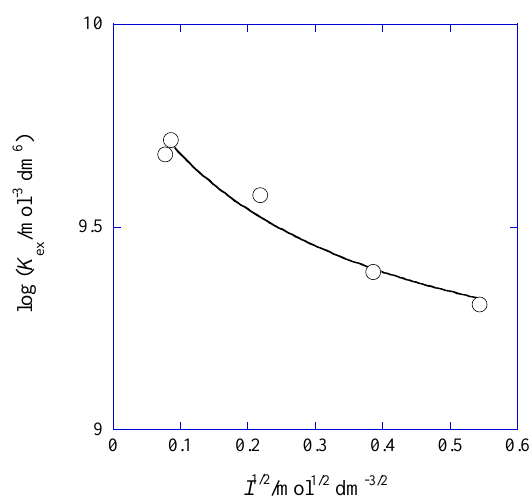
Figure 5. Plot of log K ex versus I 1/2 for the Pb(II) extraction with Cd(NO 3 ) 2 and B18C6 into Bz. The line is based on Equation (12a).